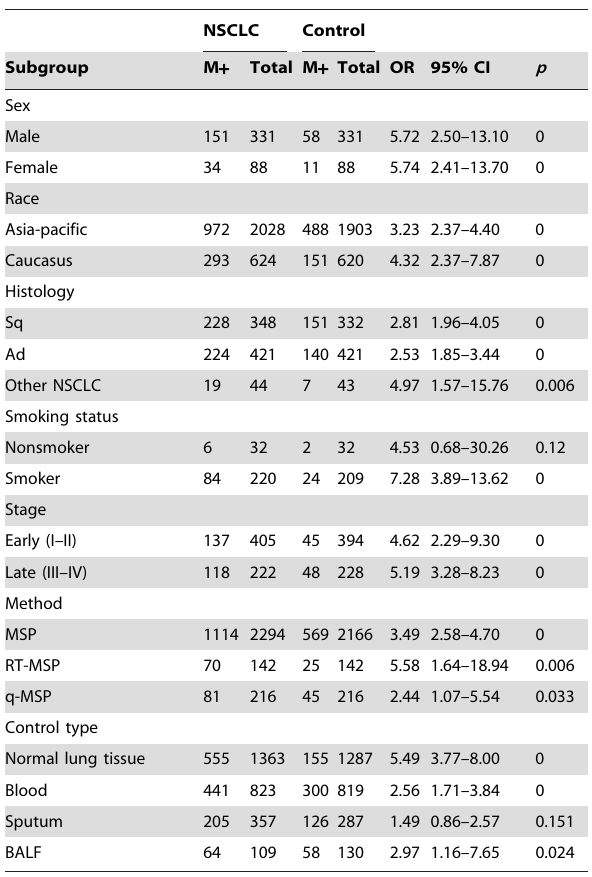
Table 3. Subgroup analysis.